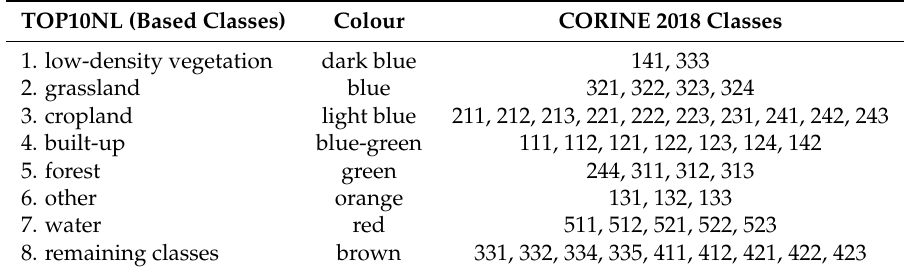
Table 6. Re-classification of the CORINE Land Cover 2018 data set according to the TOP10NL-based reference